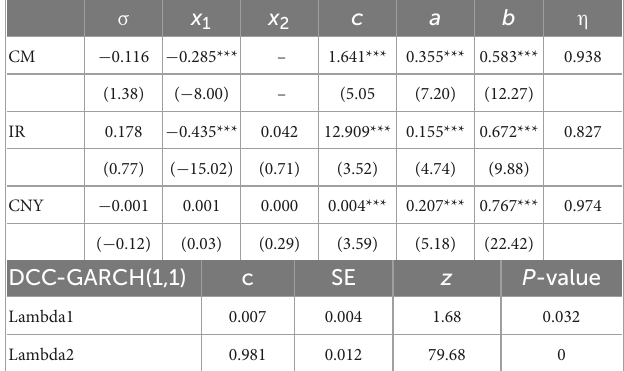
TABLE 4 DCC-GARCH estimation results.